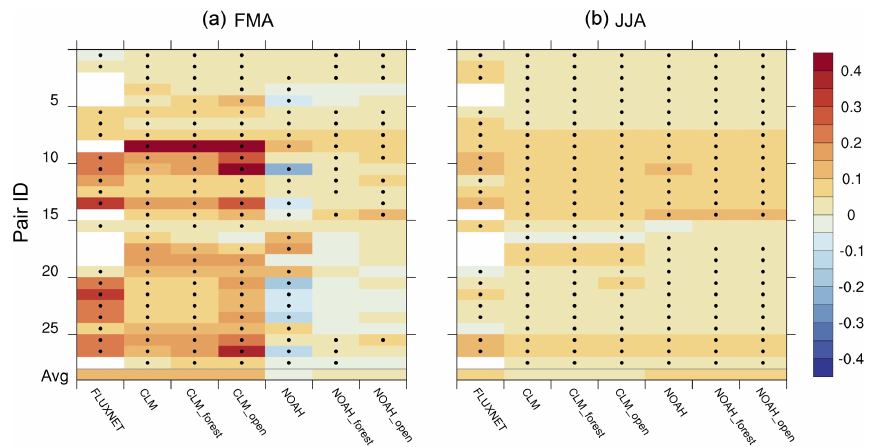
Figure 12. Change (open − forest) in observed and simulated daytime albedo during late winter/early spring (FMA, a ) and summer (JJA, b ). White areas indicate missing